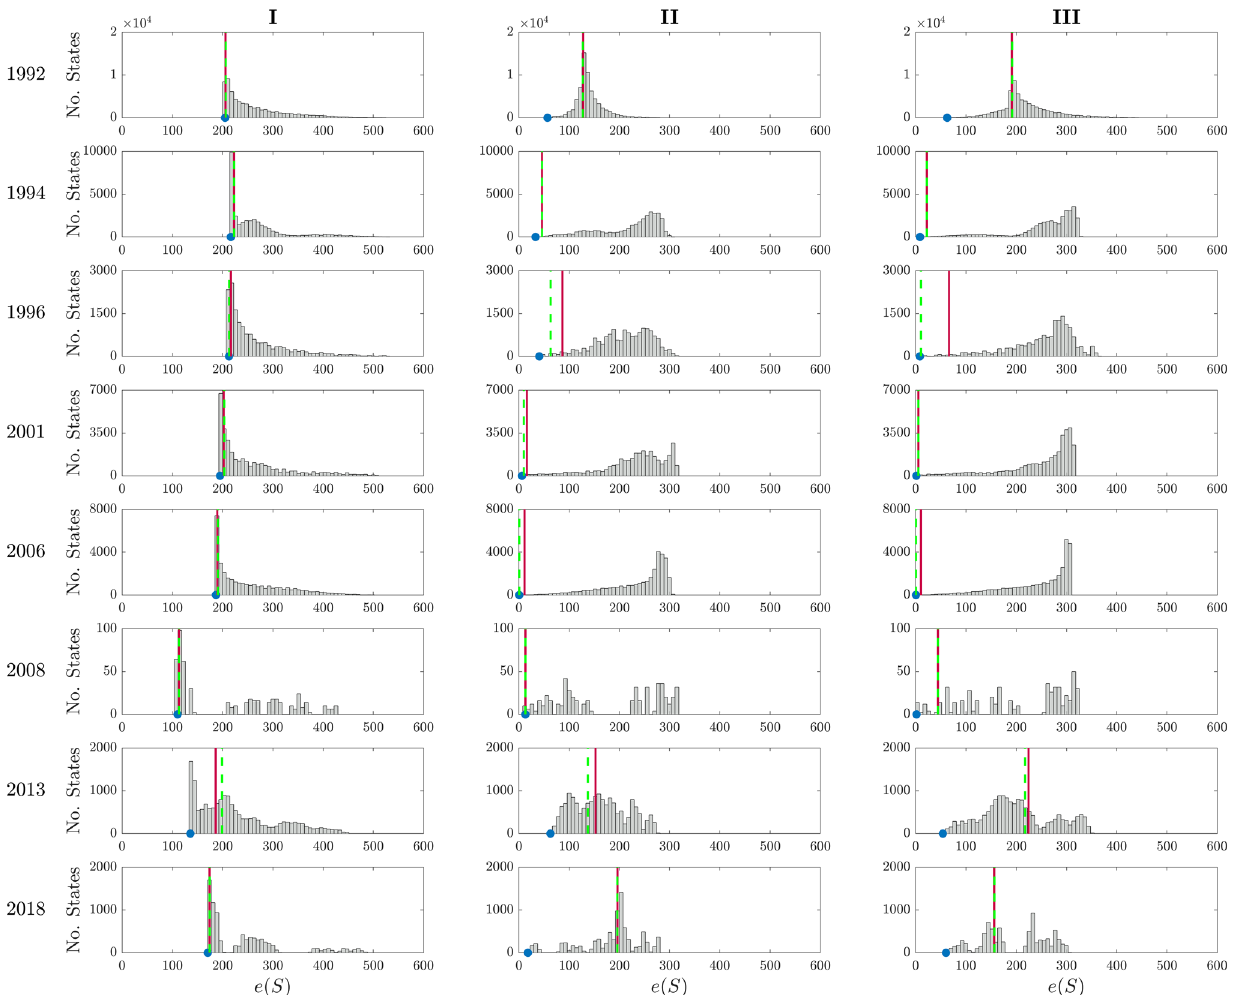
Figure 5. Energy landscape in Italy for each scenario ( I , II and III ) and election, i.e., values of the energy e ( S ) calculated according to Eq. (1) for all the 2 n p ( n p = no. parties in the parliament) choices of } , S i = s i I c S = diag { S 1 , . . . , S n , s i = ± 1 . The blue dot indicates the minimum of such energy functionals, i p i.e., the frustration (2). The red line represents e ( S gov ) , i.e., the value of the energy functional corresponding to the government, while the dashed green line represents e ( S gov + supp ) , i.e., the value of the energy